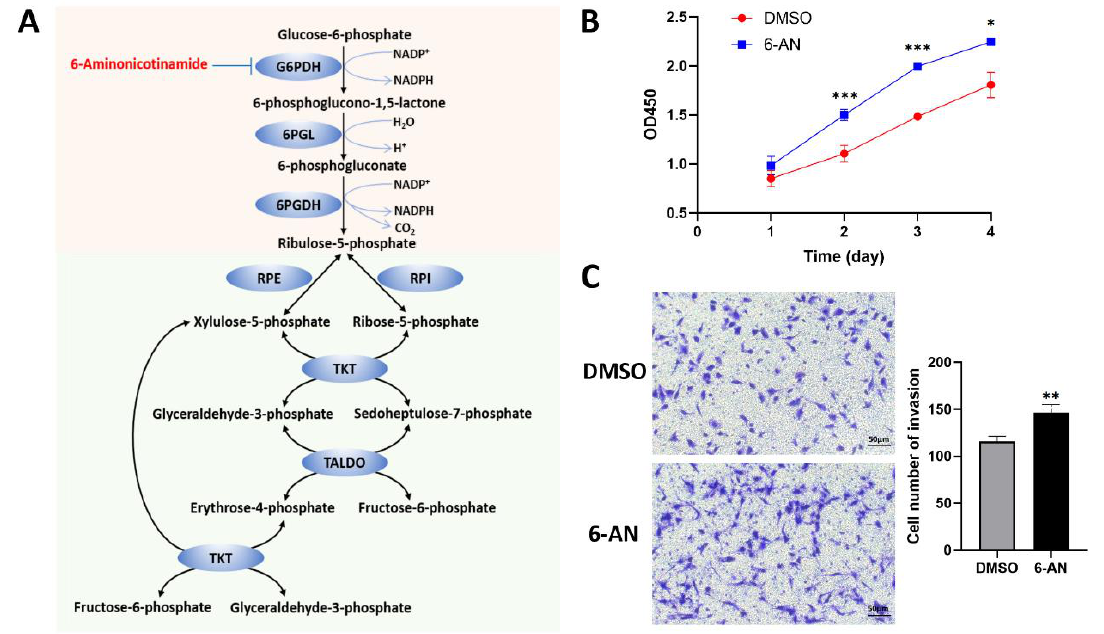
Figure 4. Ex vivo inhibition of PPP promotes cell proliferation and invasion of LPS853. (A) The pentose phosphate pathway and its inhibitor 6-AN. ( B ) The effects of 6-AN on the proliferation of LPS853 were determined via CCK-8 assays. ( C ) The effects of 6-AN on the invasion of LPS853 were determine via Transwell assays. Representative images of cell invasion and statistical analysis of specific invaded cell numbers were shown. *, p < 0.05; **, p < 0.01; ***, p < 0.001. G6PDH, glucose-6